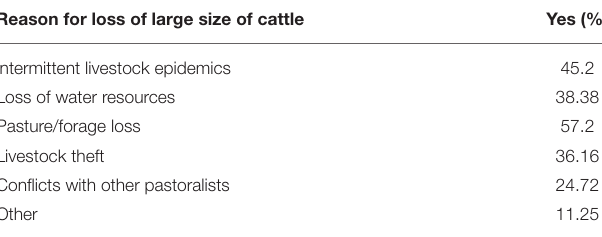
TABLE 3 | Extent to which perceptions of gender equality among pastoralist men have changed.